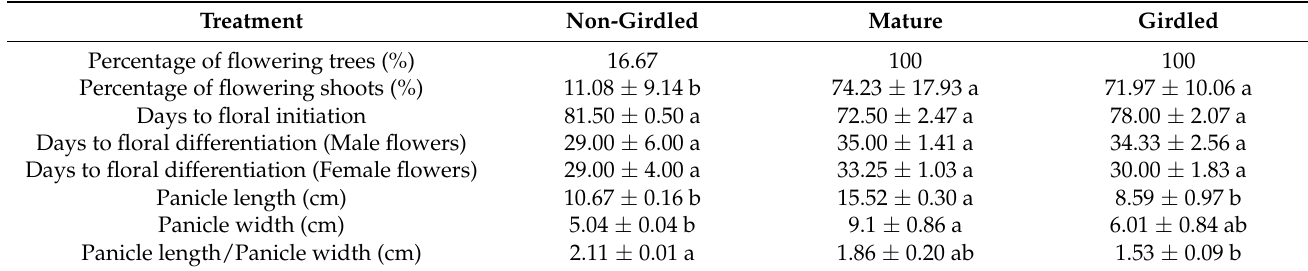
Table 1. Litchi flowering time and quantities in response to girdling and cold temperature treatment.